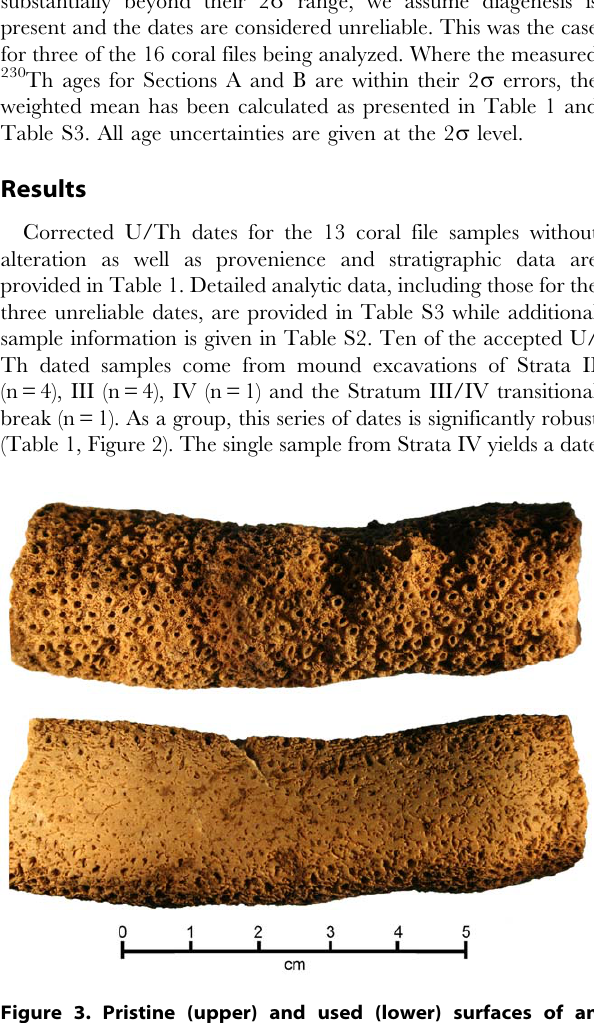
Figure 3. Pristine (upper) and used (lower) surfaces of an Acropora coral file (Lab # 024) dated for this study. Note the